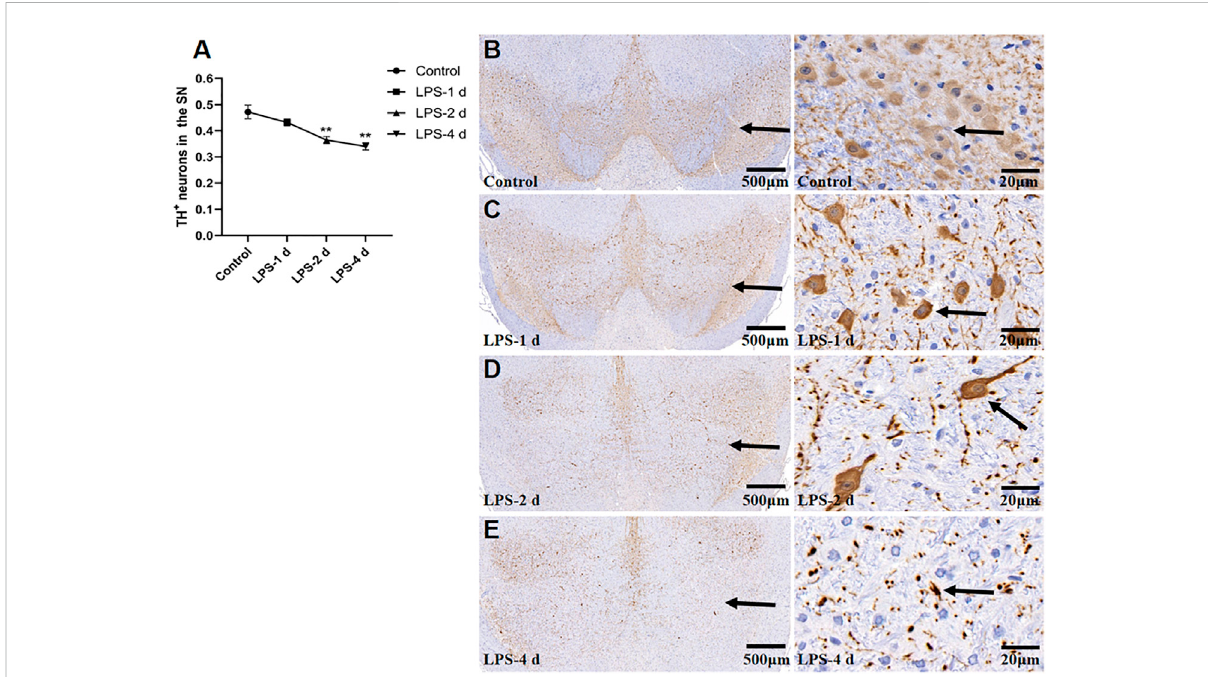
FIGURE 10 Tyrosine hydroxylase (TH) + neurons in the SN for all groups ( n = 3). (A) The AOD value of each group was compared. Data are expressed as the mean±SEM.** p < 0.01,comparedtothecontrolgroup. (B) Representative photomicrographsofTH + neuronsinthecontrolgroup(Left:×16,Right: ×400). (C) Representative photomicrographs of TH + neurons in the LPS-1 d group (Left: ×16, Right: ×400). (D) Representative photomicrographs of TH + neuronsintheLPS-2dgroup(Left:×16,Right:×400). (E) RepresentativephotomicrographsofTH + neuronsintheLPS-4dgroup(Left:×16, Right: ×400). The arrows showed the expression of TH + neurons.